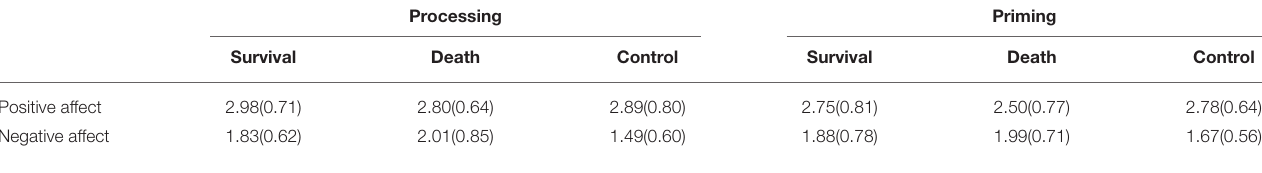
TABLE 2 | Descriptive data of Positive and Negative Affect Schedule (PANAS) in experiment